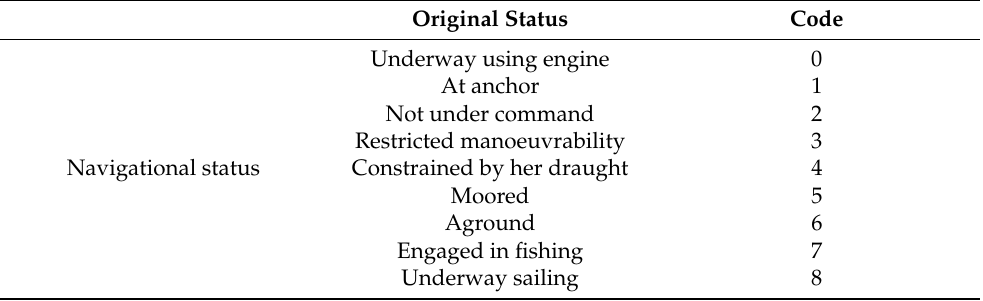
Table 1. Original AIS (NMEA) navigational status of ships and substituting codes.